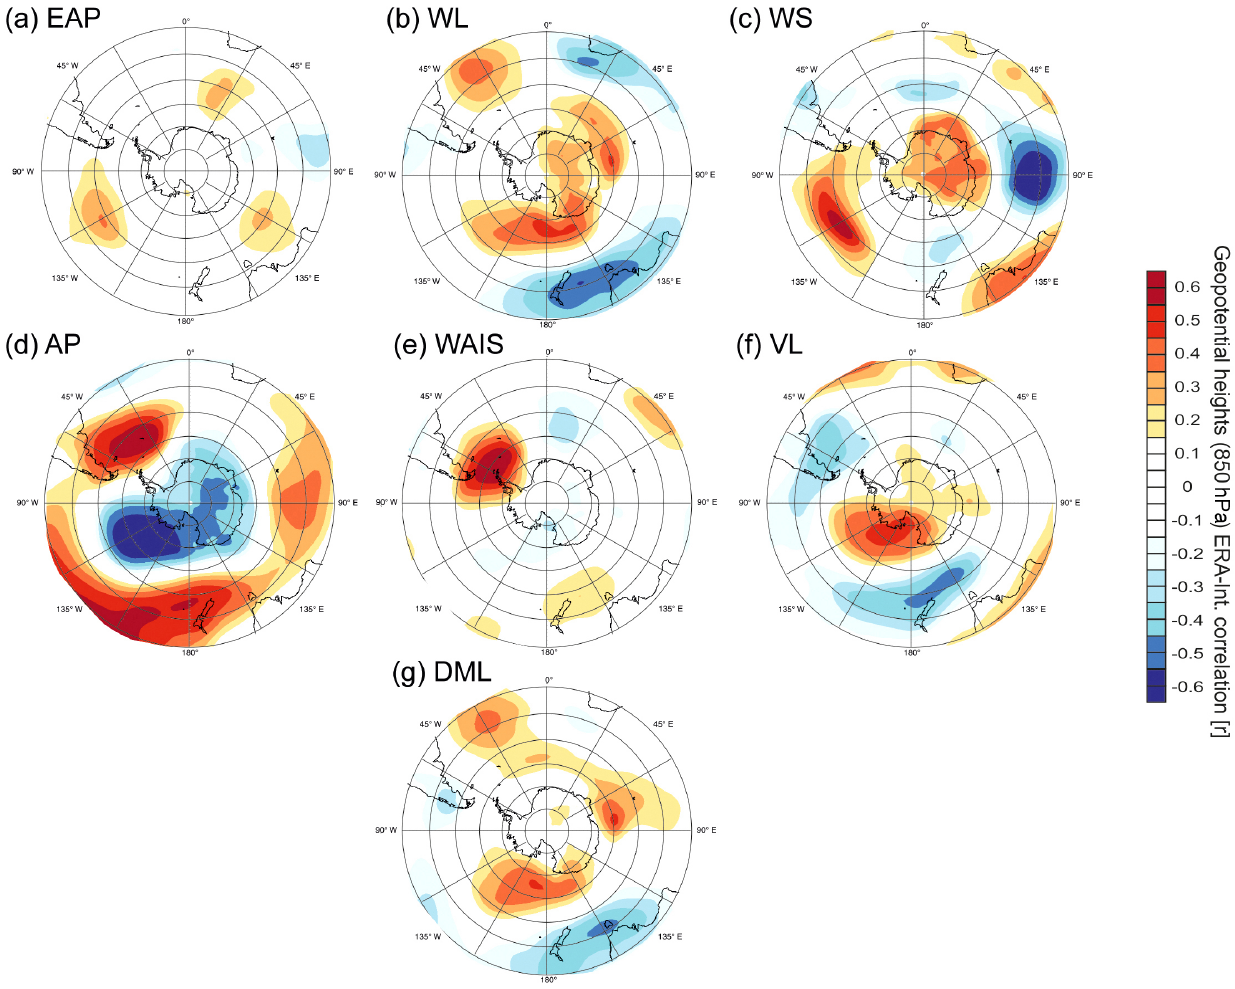
Figure 4. Spatial correlation plots of standardized regional snow accumulation composites with annual 850hPa geopotential heights from ERA-Interim (1979–2010). Grid points with >95% significance are dotted. Note that correlation with WS only covers the period